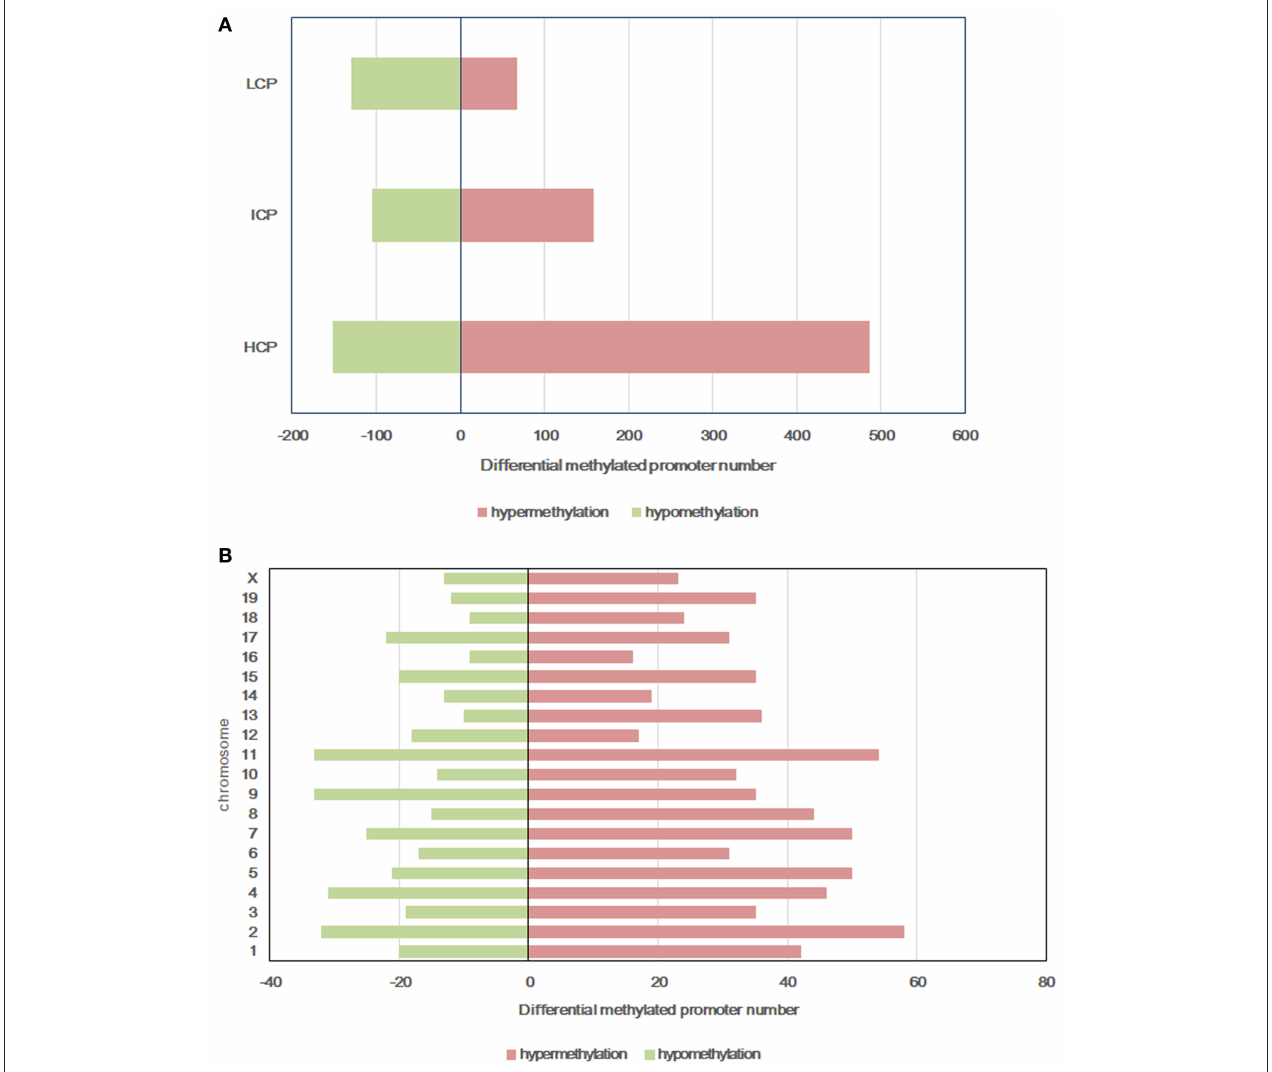
FIGURE 3 | Differentially methylated promoters between HF-CON group and CON-CON group. (A) CpG density of differentially methylated promoters. (B) Chromosomal distribution of differentially methylated promoters. Red: differentially hypermethylated promoters; Green, differentially hypomethylated promoters. Classification of all promoters with high (HCP), intermediated (ICP), and low (LCP) CpG